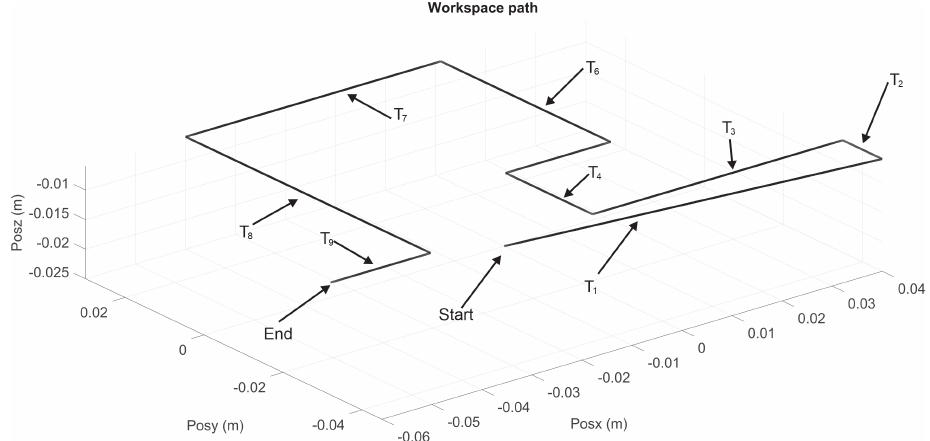
Figure 9. Transects T i trajectories for right haptic device for MCM